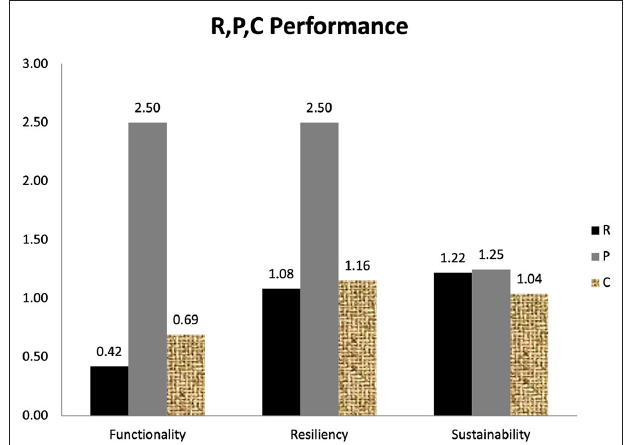
FIGURE 2 | R, P, C scores of South Windsor Stormwater System.